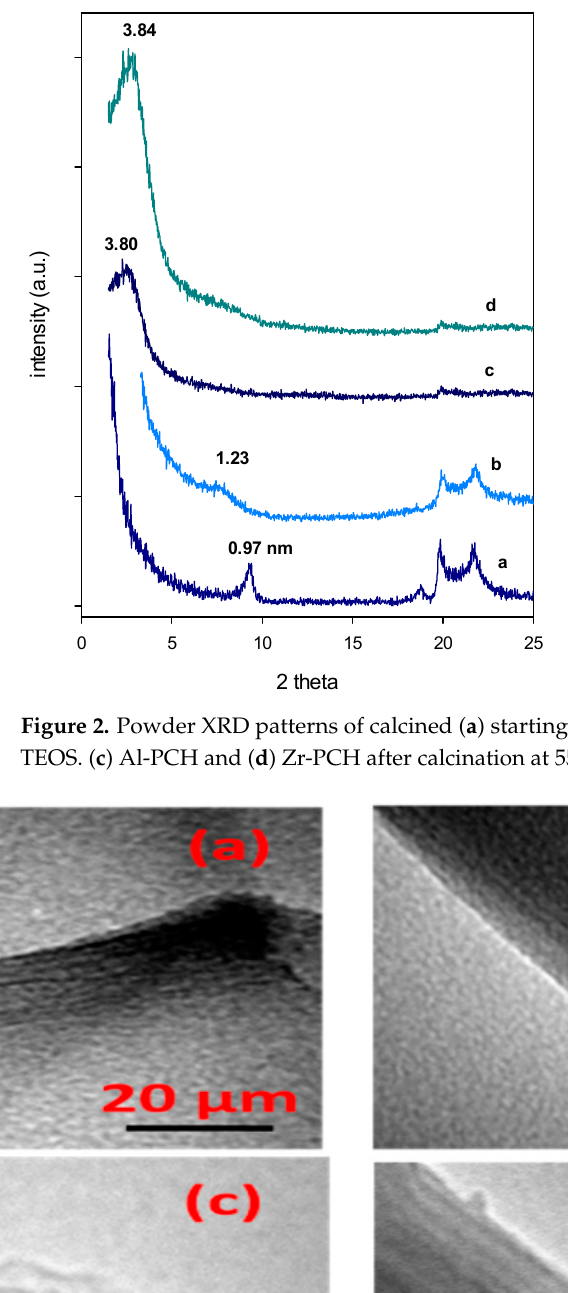
Figure 2. Powder XRD patterns of calcined ( a ) starting raw, ( b ) after reaction with C 12 amine, and TEOS. ( c ) Al-PCH and ( d ) Zr-PCH after calcination at 550 °C.